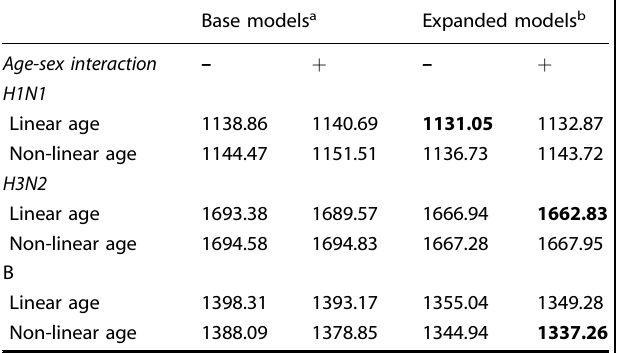
Table 4. Goodness-of- fi t comparison of pre-vaccination age models. Base models